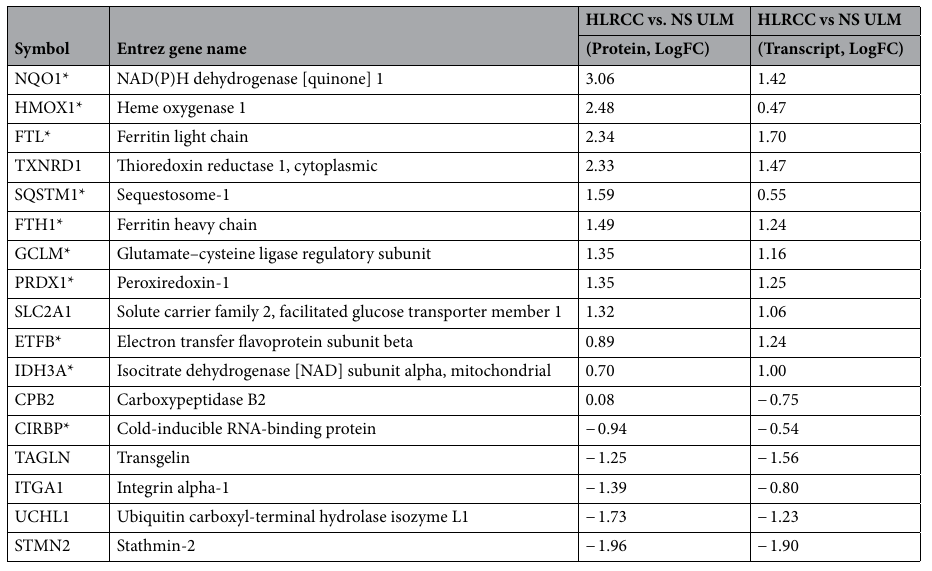
Table 1. Protein and transcript alterations in HLRCC versus Non-Syndromic ULMs. with antioxidant response element (ARE) promoter binding motifs. Candidates designated with a * exhibit concordant abundance trends between HLRCC and NS ULMs in Vanharanta et al. 20 .